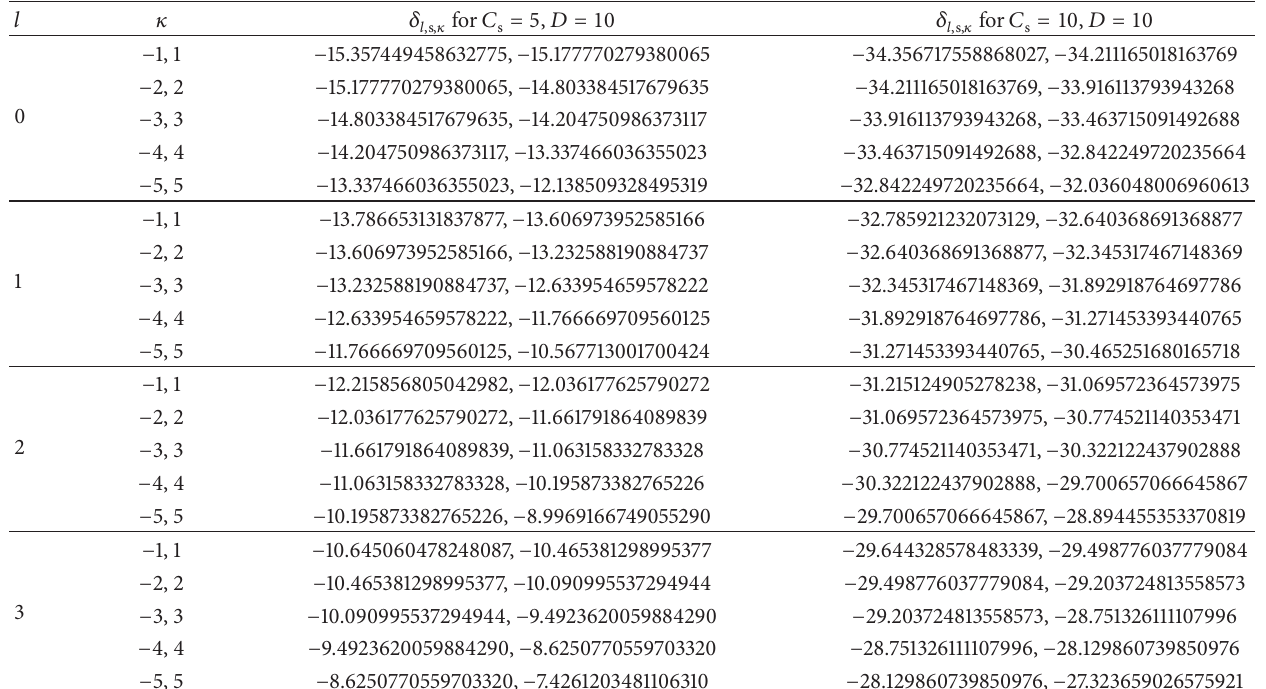
Table 5: Spin scattering phase shifts for hyperbolical potential with positive potential parameter 𝜎 0 = 0.50, 𝛼 = 0.50 , 𝑐 𝑜 = 1/12 , and 𝐸 = 1 . The relativistic mass is 𝑚 = 1 in atomic units (𝑚 = 7 = 1) .